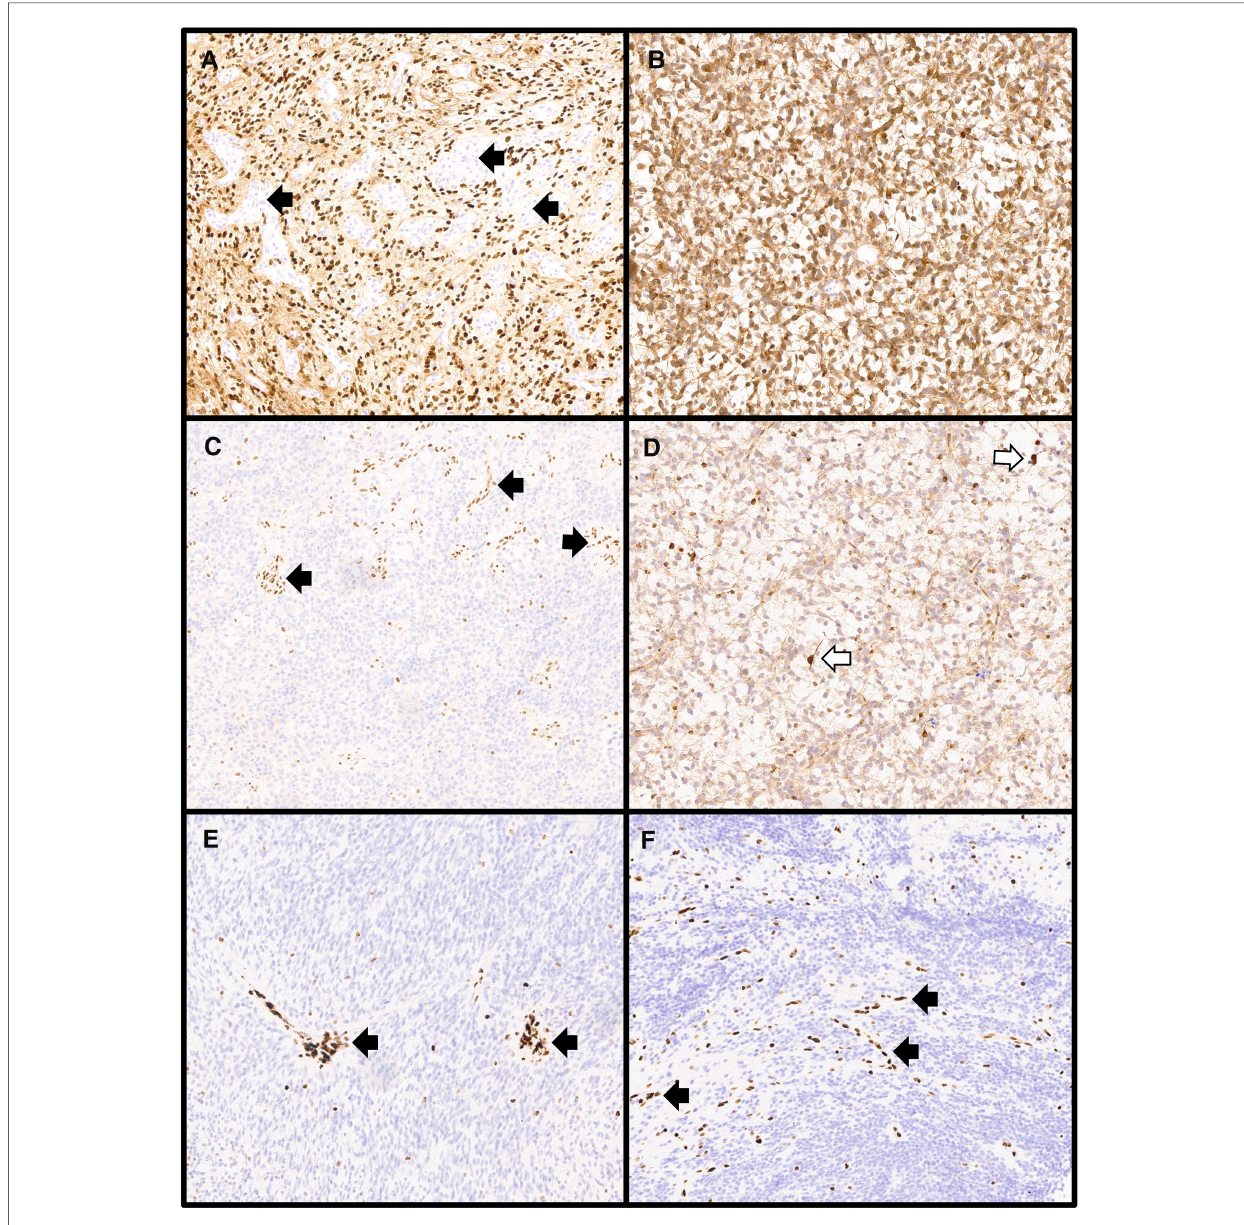
FIGURE 2 Immunohistochemical stains used in the molecular workup of central nervous system tumors. ( A ) Diffuse midline gliomas harboring the canonical H3 p.K28M (H3 p.K27M) alteration show diffuse nuclear positivity for the H3K27M immunostain while entrapped normal tissues including vessels (black arrows) are negative (H3K27M immunostain, 100× magni fi cation). ( B ) IDH-mutant gliomas with the most common mutation (IDH1 p.R132H) will show cytoplasmic positivity for the IDH1-R132H immunostain as was seen in this astrocytoma, IDH-mutant, CNS WHO grade 3 (IDH1-R132H immunostain, 100× magni fi cation). ( C ) Atypical teratoid/rhabdoid tumors with alterations in SMARCB1 show loss of nuclear staining for INI1 with retained staining in non-neoplastic tissues including vessels (black arrows) (INI1 immunostain, 100× magni fi cation). ( D ) Mutations in ATRX can be observed in several gliomas including astrocytoma, IDH-mutant as shown here. Alterations result in loss of nuclear ATRX immunostaining while retained nuclear staining is present in cells with the wildtype ATRX protein, including entrapped non-neoplastic glial cells (white arrows) (ATRX immunostain, 100× magni fi cation). Loss of nuclear staining in the tumor nuclei for H3 p.K28me3 (H3K27me3) is seen in diffuse midline gliomas, H3 K27-altered, including those with non-canonical H3 p.K28M (H3 p.K27M) alterations ( E : H3K27me3 immunostain, 100× magni fi cation) and in posterior fossa group